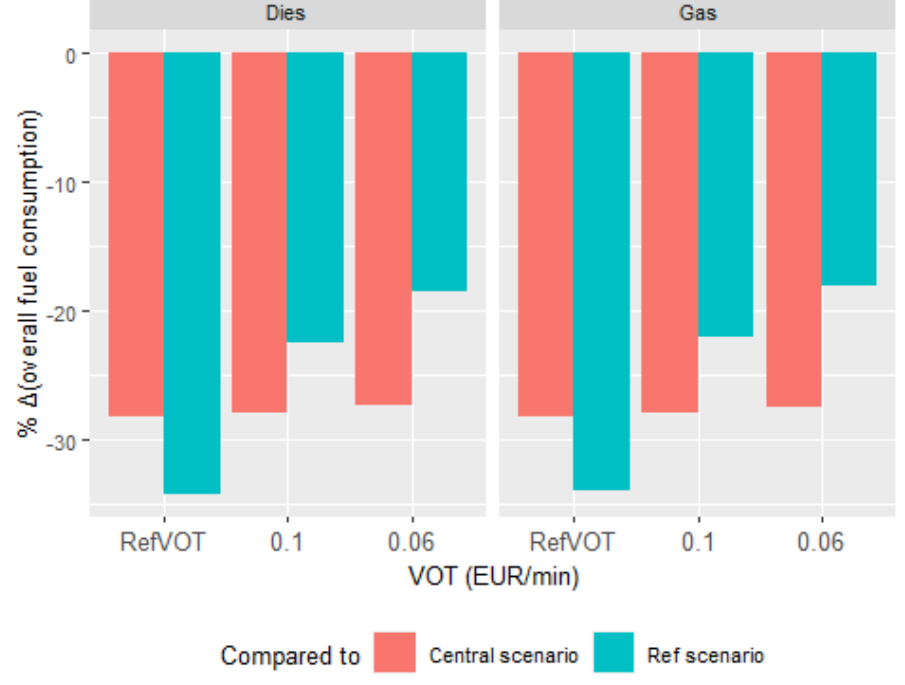
Figure 9. Sensitivity scenario for fuel consumption : impact on total fuel